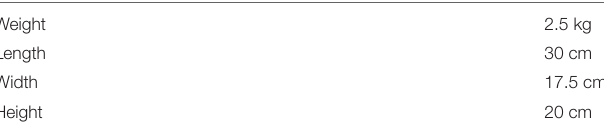
TABLE 1 | The weight and dimensions of